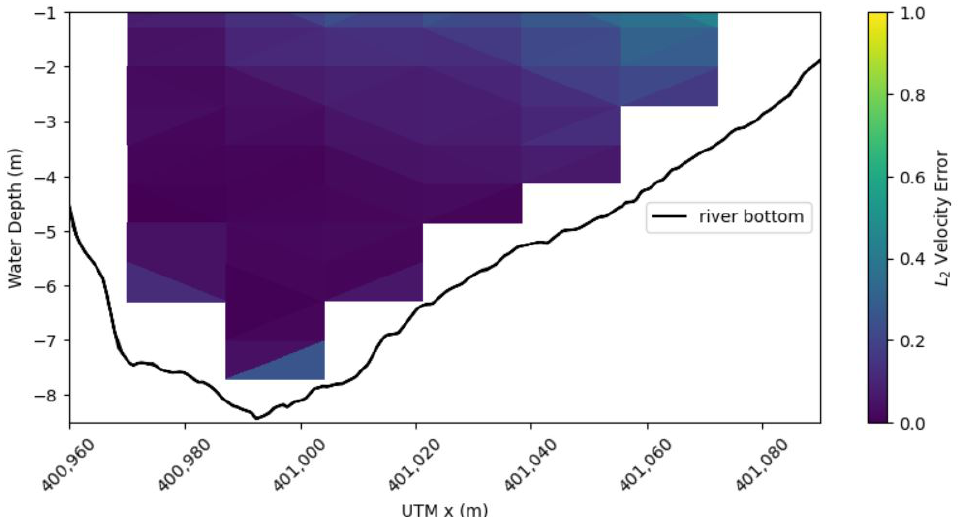
Figure 9. L 2 error between ADCP velocity magnitude and Delft3D velocity magnitude using Equation (2).